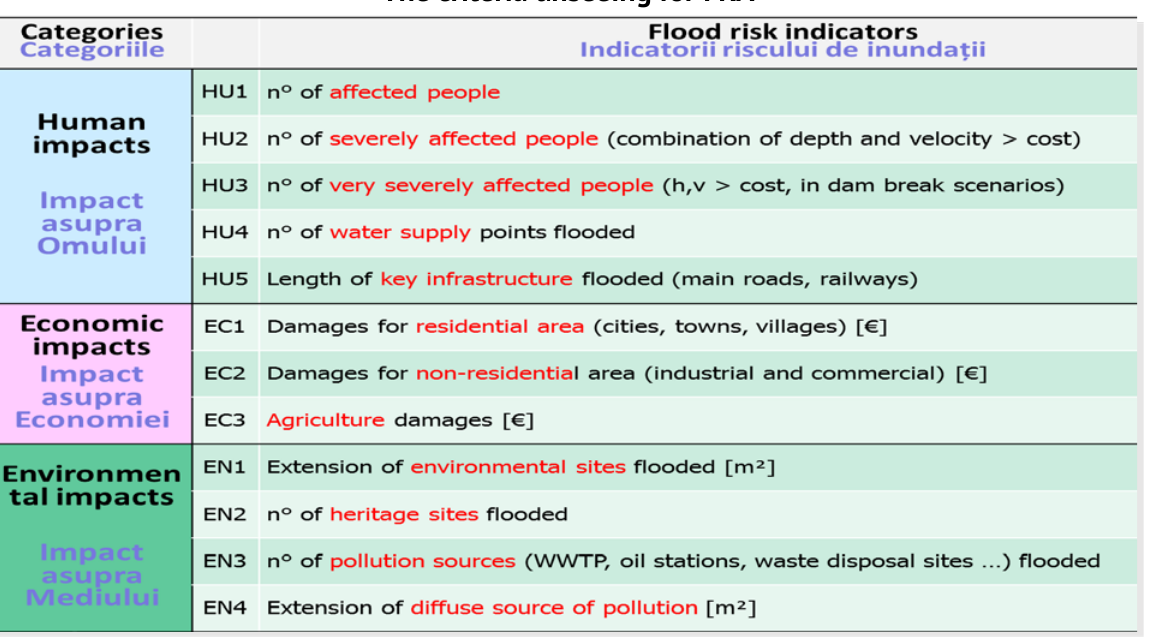
The criteria unseeing for